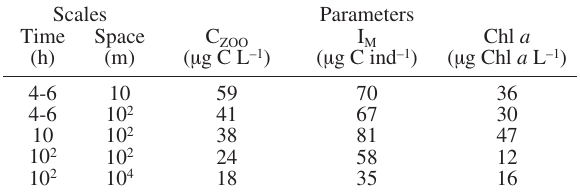
Table 3. – Variability (CV, %) of zooplankton biomass, C L –1 ), individual mass, I (µg C ind. –1 ), and Chl a , (µg chlorophyll a M L –1 ) at the time- and space scales explored during the